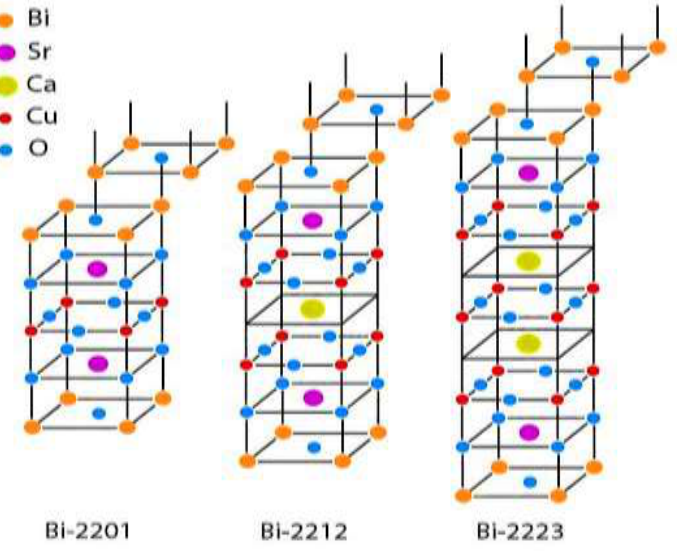
Figure 11: The crystal unit cells of BSCCO family in different